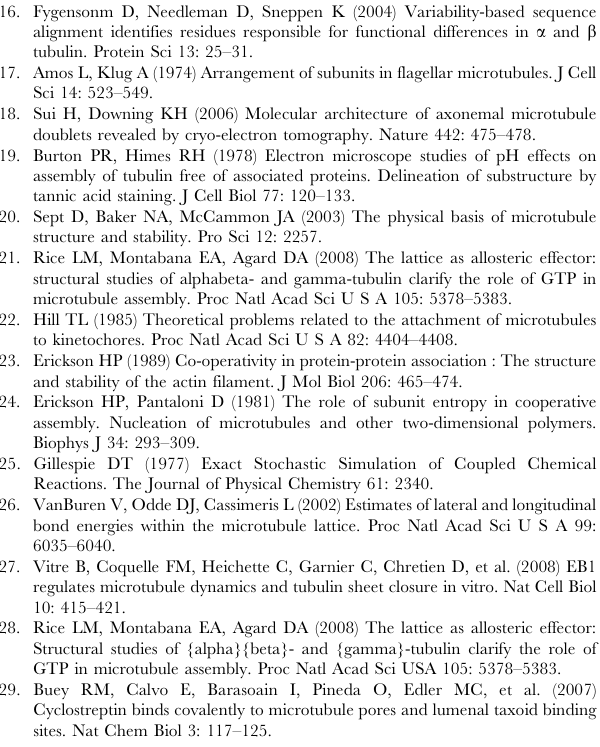
Figure S4 Effects of variable D G TuTu on the assembly structures using the Scheme 2 described in Fig. S3b. (0, 2, 4, and 6 k B T, as indicated by corresponding circled numbers). Different D G TuTu correspond to different temperatures as showed in Fig. S3b and